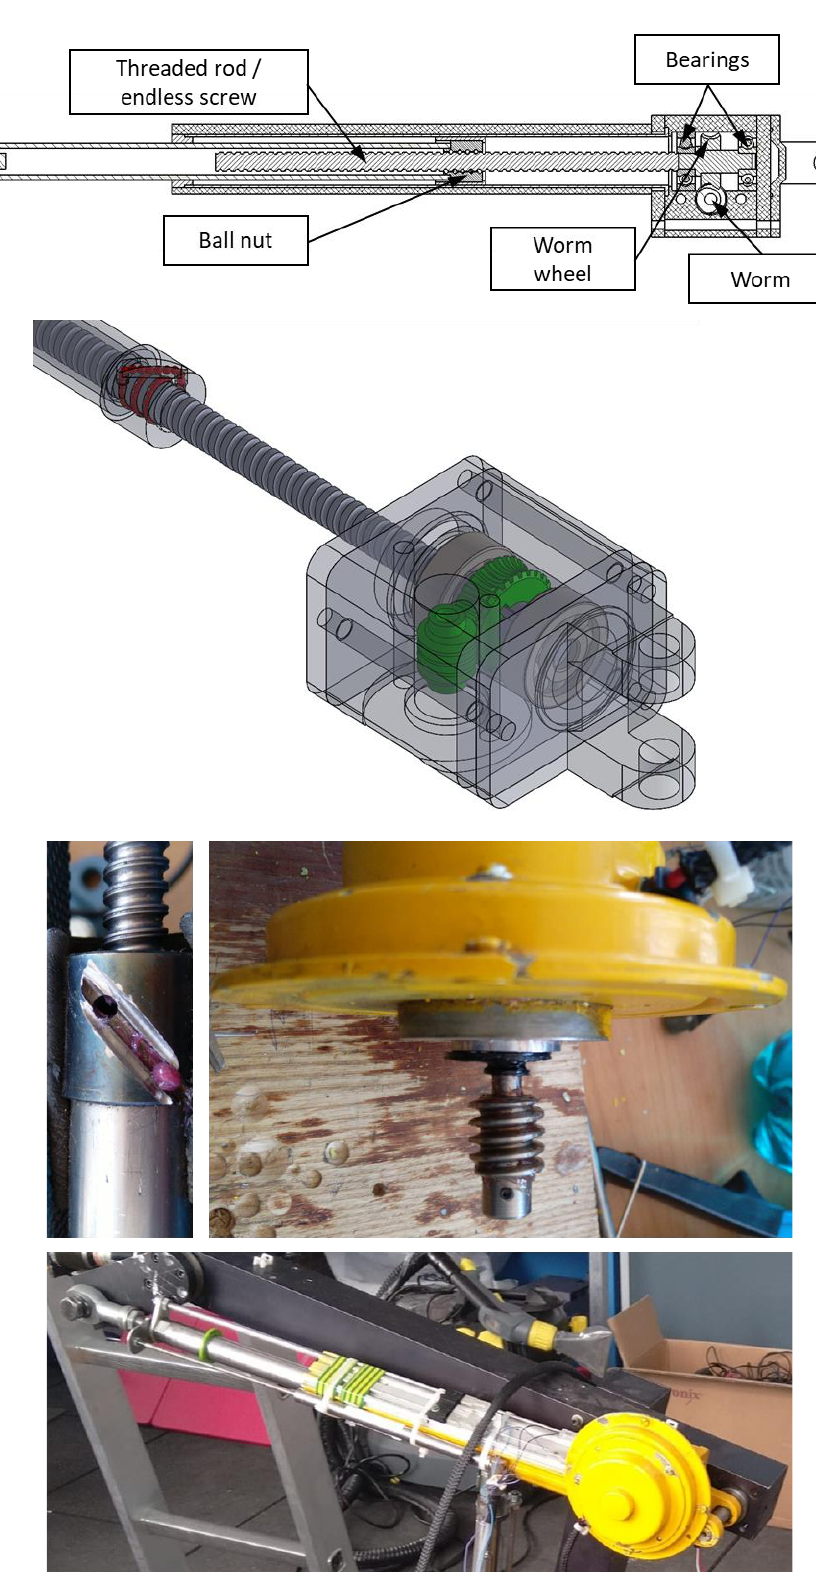
Figure 11. In this figure, we show the representation (cross-section) of a linear motor. A brushless DC motor drives the screw. By means of the worm gear – worm wheel, the movement is transmitted to the ball screw that acts on the nut, removing or bringing the left joint closer to the right one.